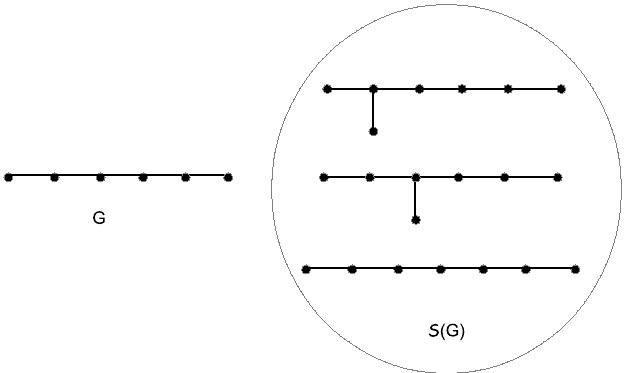
Figure 4. Hexane G and graphs in the set S ( G ) with GED = 2 with respect to G .